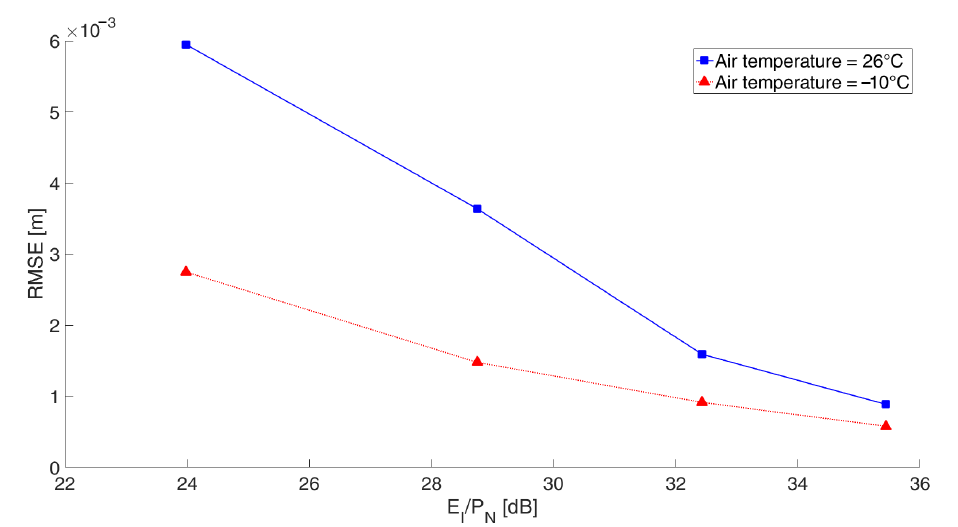
Figure 13. RMSE vs. E I / P N for different